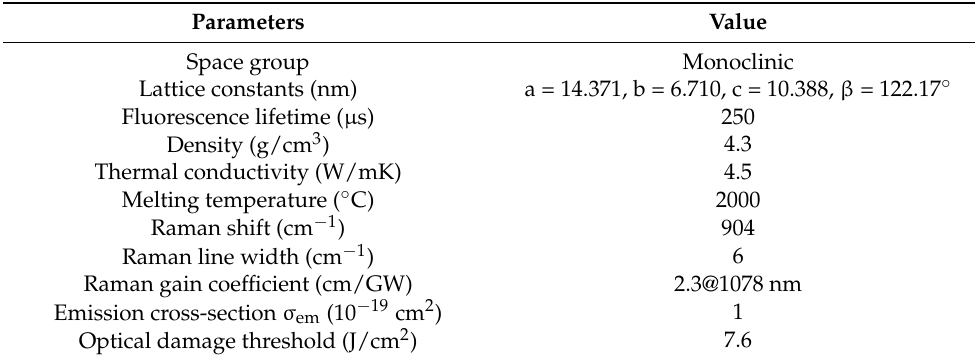
Table 9. Property parameters of Nd:Y 2 SiO 5 crystal [110].